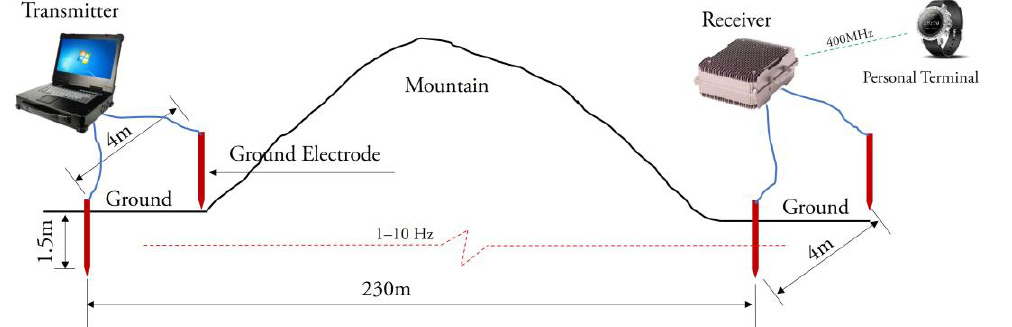
Figure 6. Test structure.